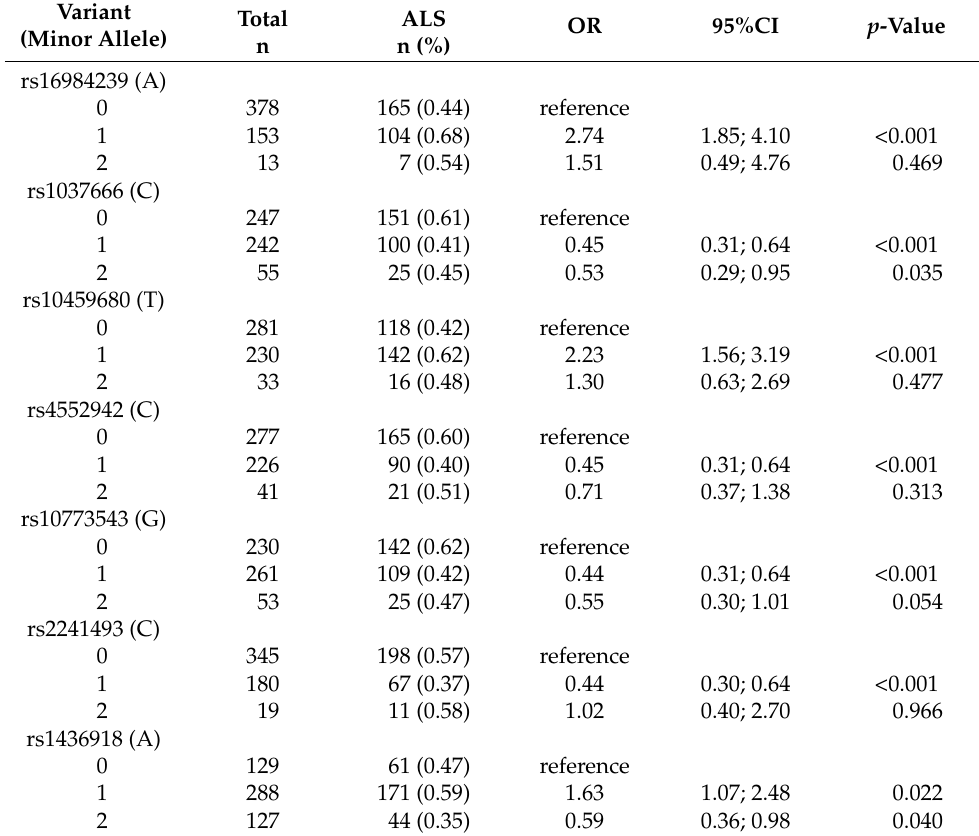
Table 1. Non-adjusted odds ratio for amyotrophic lateral sclerosis according to the prioritized single-nucleotide polymorphisms in the first step of the group LASSO regularization.